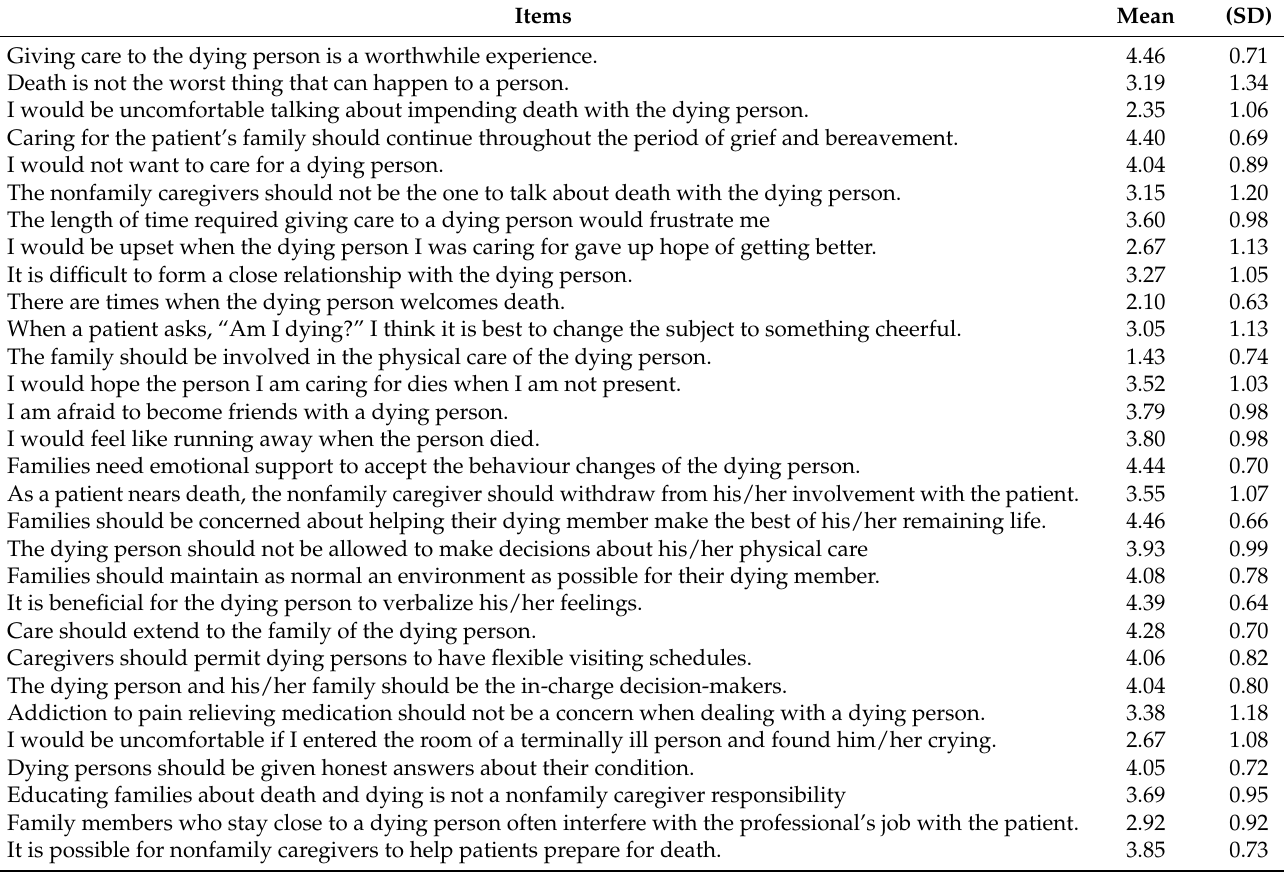
Table 3. Results of Frommelt Attitude Toward Care of the